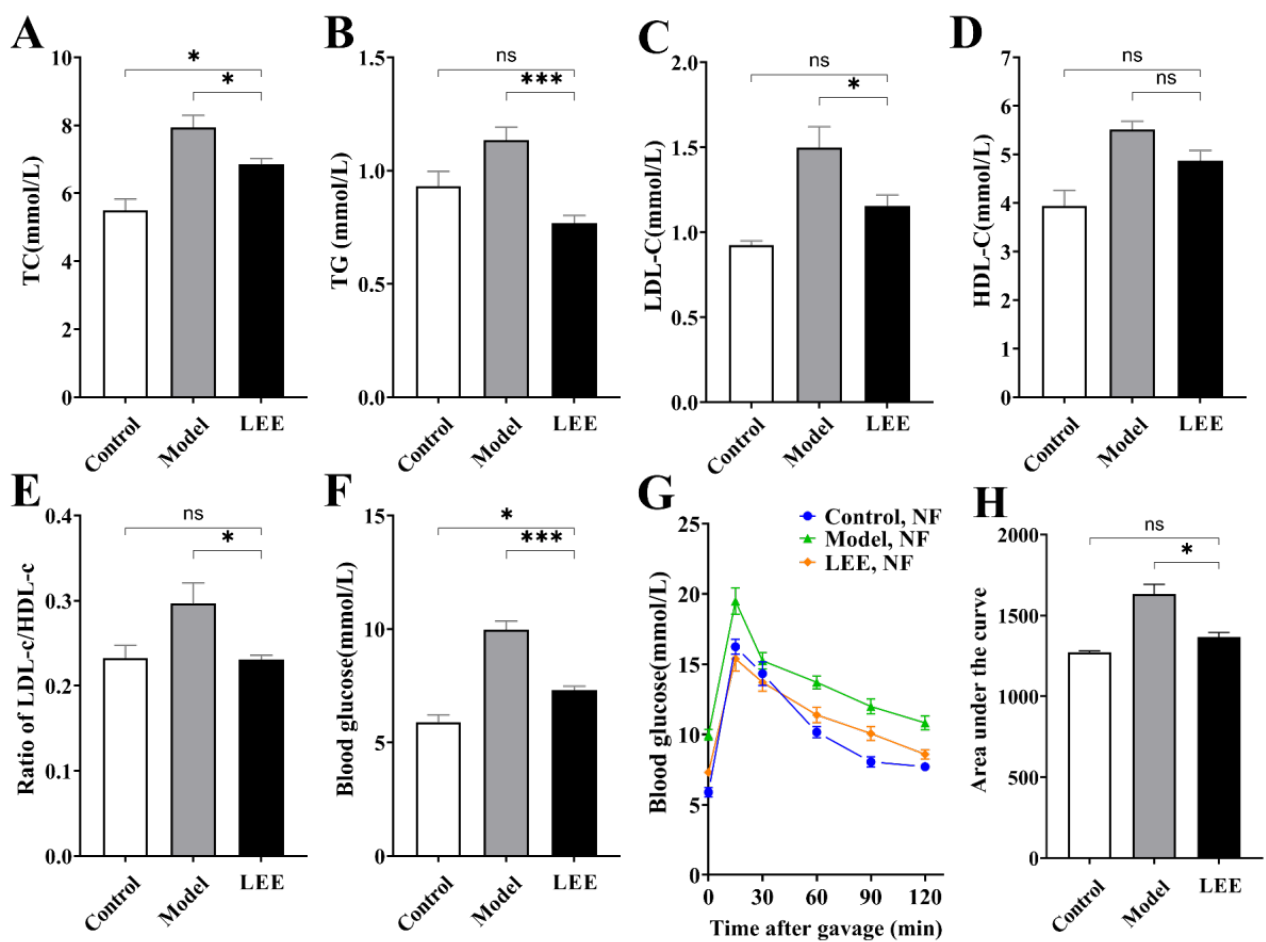
Figure 2. LEE improves dyslipidemia and glucose tolerance in HFD mice. Serum TC ( A ), TG ( B ), LDL-c ( C ), HDL-c ( D ), ratio of LDL-c/HDL-c € , blood glucose ( F ), OGTT ( G ), and area under the OGTT curve ( H ). Data are expressed as the mean ± SEM ( n = 6). * p < 0.05; ** p < 0.01; *** p < 0.001; ns, not significant.